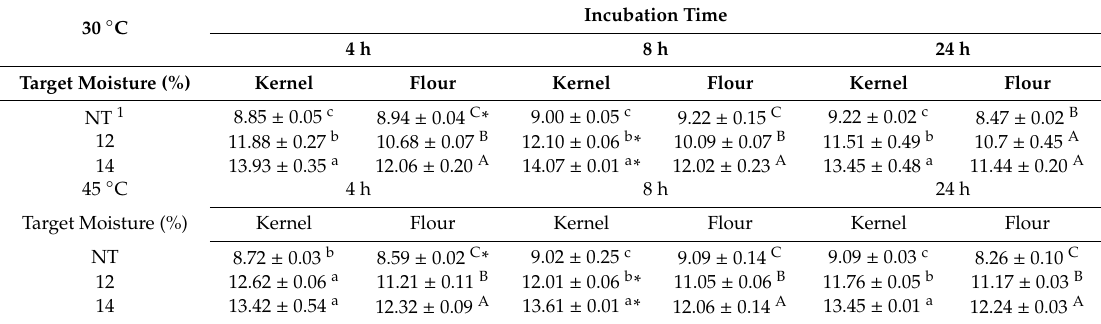
Table 1. Intermediate wheatgrass kernel and flour moisture as a ff ected by tempering conditions.